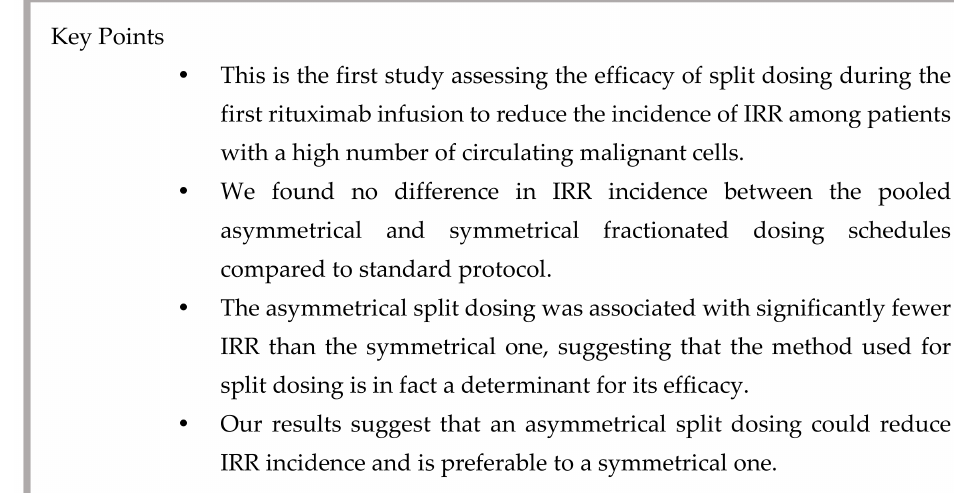
Figure 2. Key Points. IRR: Infusion-related